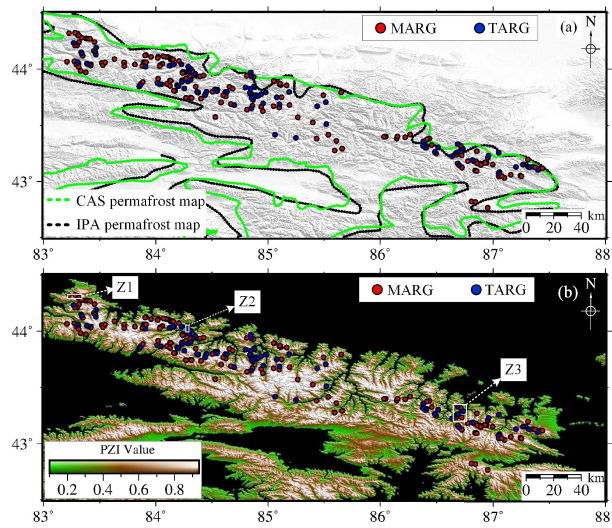
Figure 9. Comparison between the mapped ARGs and existing per- mafrost maps. The green and black dashed lines in (a) show the mountain permafrost boundaries of CAS permafrost map and the discontinuous permafrost boundaries of IPA map, respectively. The green-to-white colors in (b) show the global Permafrost Zonation Index (PZI) values. Areas without PZI values are shown in black. The PZI maps for the three selected zones “Z1”, “Z2”, and “Z3” in (b) are further shown in Fig. 10. The red and blue dots mark the locations of MARGs and TARGs,